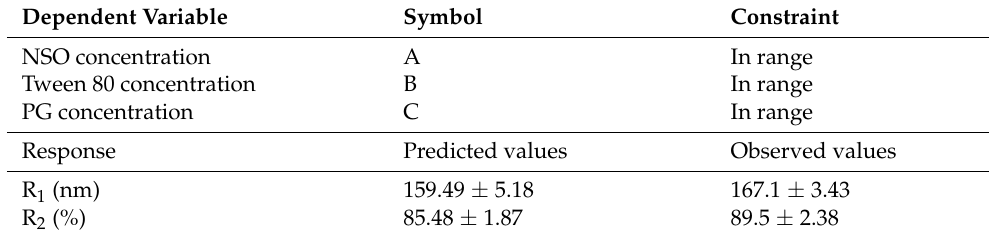
Table 4. Predicted and observed values for the optimized PGZ-loaded NE